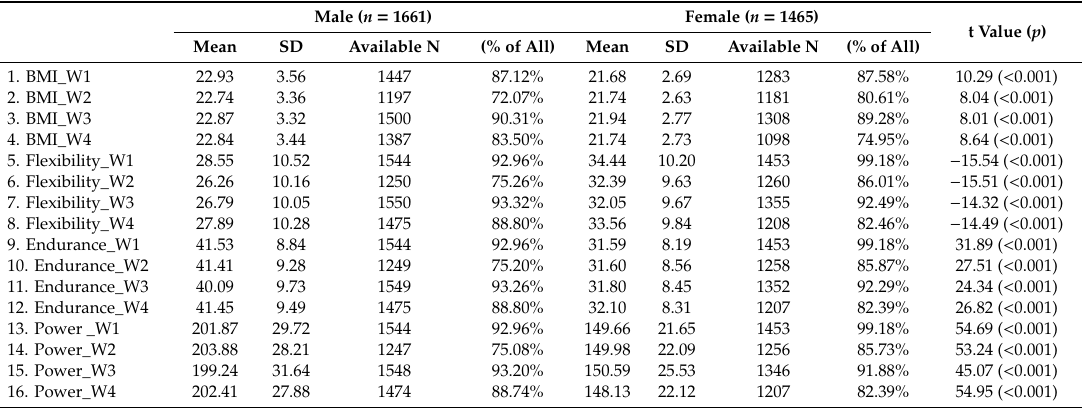
Table 2. Means, standard deviations (SD), and sample size (N) of main